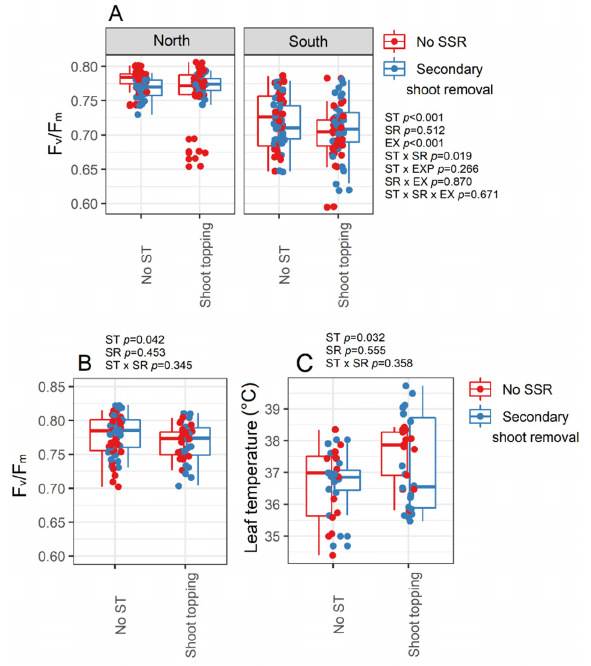
Figure 4. Maximum quantum yield of PS II in dark-adapted samples collected in 2020 with a PAM 2000 on the north- and south-exposed side of the row ( A ) and collected in 2019 with the HandyPEA ( B ) for plants subjected to shoot topping or shoot bundling (no ST) where secondary shoots were either removed (secondary shoot removal) or not (no SSR) (n = 24). ( C ) The dynamic of leaf temper- ature collected in 2019. In the graphs, points represent raw data, horizontal lines within boxes indi- cate the median, and boxes indicate the upper (75%) and lower (25%) quartiles. Whiskers indicate the ranges of the minimum and maximum values. Data were analyzed with three- (2020) and two- way (2019) ANOVA. p -values are shown in the graph (ST—shoot topping factor; SR—secondary removal factor; ST × SR—interaction). 3.4. Must Quality and Berry Temperature There were significant differences between the 2019 and 2020 seasons in terms of must quality, with 2020 (the warmer year) being characterized by lower TSS, titratable acidity, tartaric and malic acid, and anthocyanins and polyphenols as compared to 2019 ( p < 0.001) (Figure 5). No differences were noted for YAN or must pH. The SR factor was not significant for any of the parameters assessed, although significant interactions were present with ST for titratable acidity and malic acid. ST had an overall significant effect on TSS, anthocyanins and polyphenols, with plants subjected to shoot topping also show- ing lower values when compared to shoot bundling. Significant interactions were ob- served between ST and Y for TSS and YAN, as the effect of shoot topping was more pro- nounced in 2020, with reduced TSS and YAN when compared to shoot bundling.